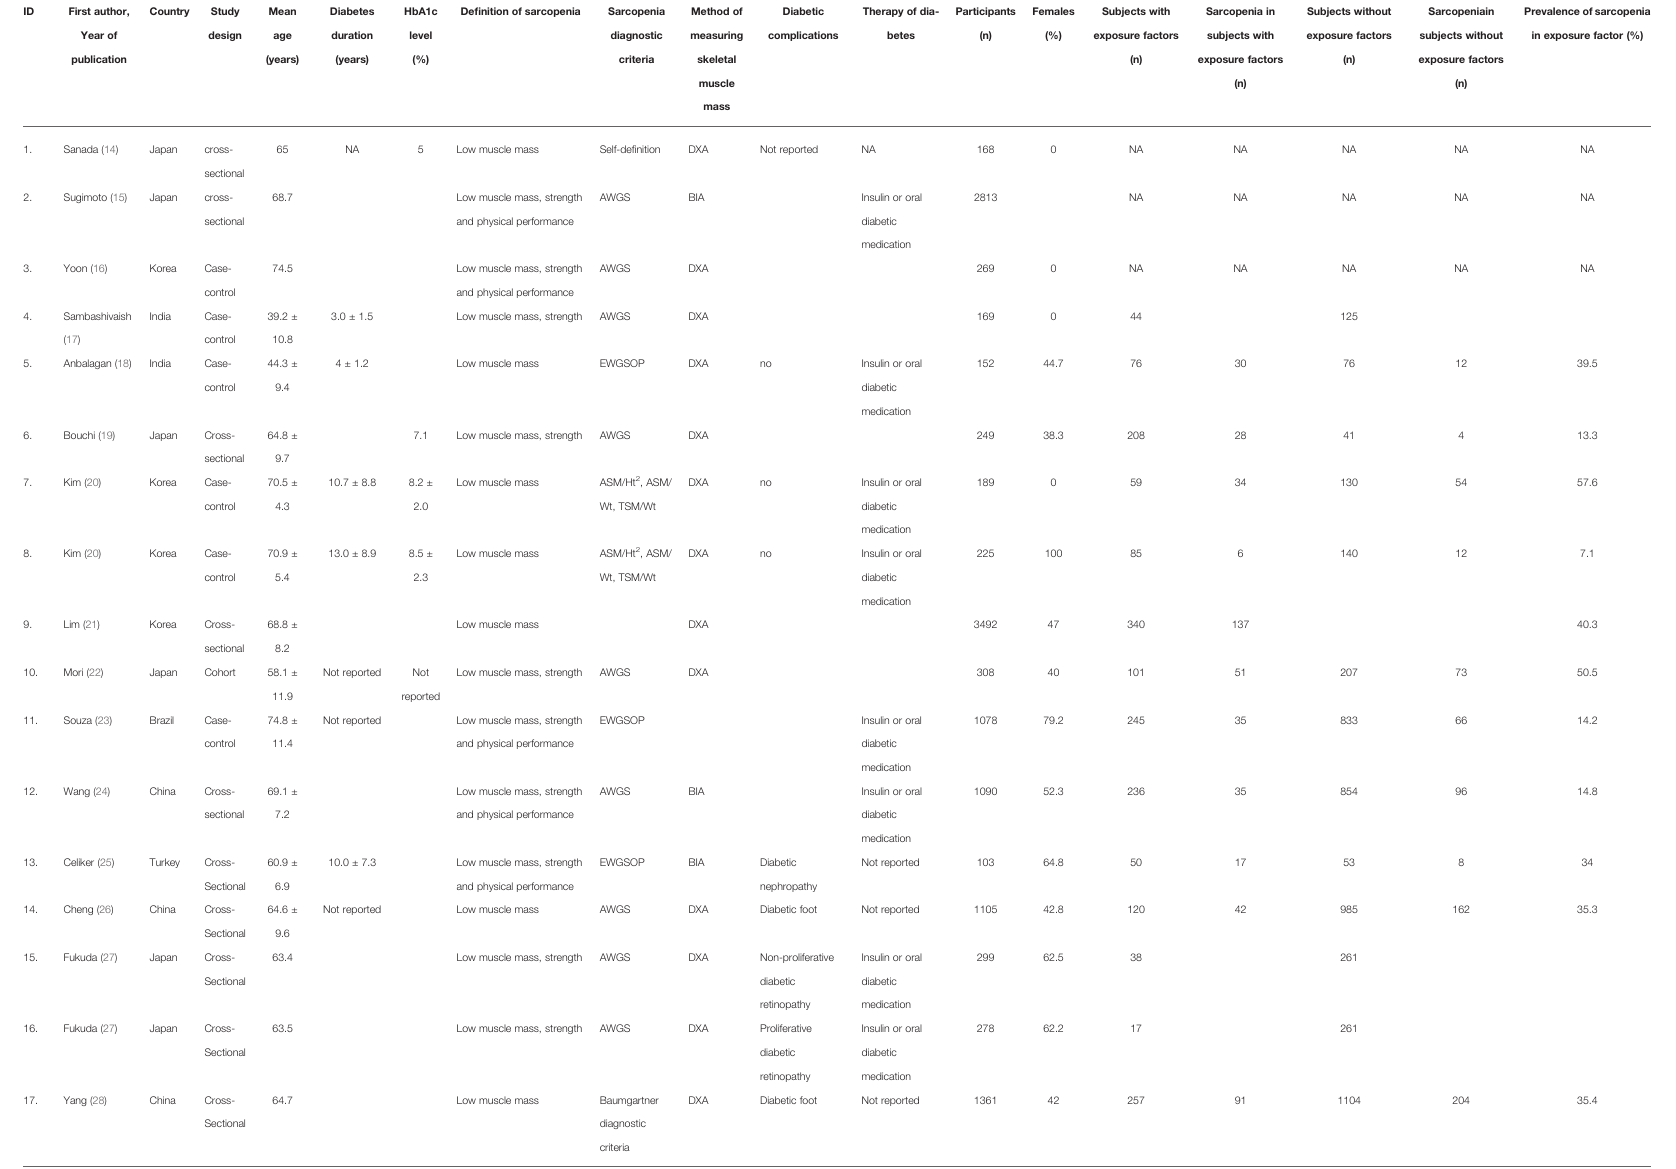
TABLE 1 | Characteristics of the included